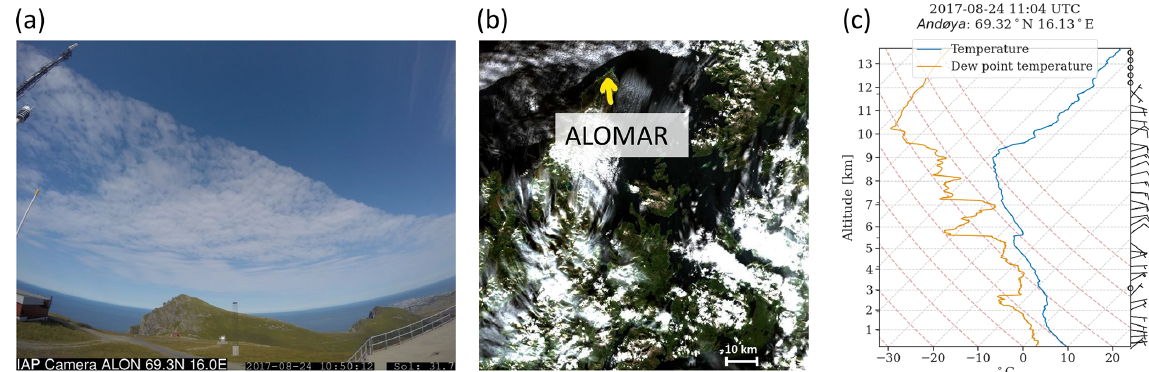
Figure 3. Images of the cloud field probed by lidar at 10:50UTC, as seen (a) from inside the ALOMAR observatory and (b) from the Sentinel-2 satellite (true color image) (Drusch et al., 2012). In the satellite image, the northern tip of the island is marked by the yellow arrow, and the cloud field probed by the lidar is directly to the north of the island. The border between cloud and clear sky that is visible in both pictures moves through the lidar’s field of view at around 10:40UTC. Temperature, dew point, and wind profiles from a radiosonde released in Andenes at 11:04UTC on 24 August 2017 are given in panel (c) .